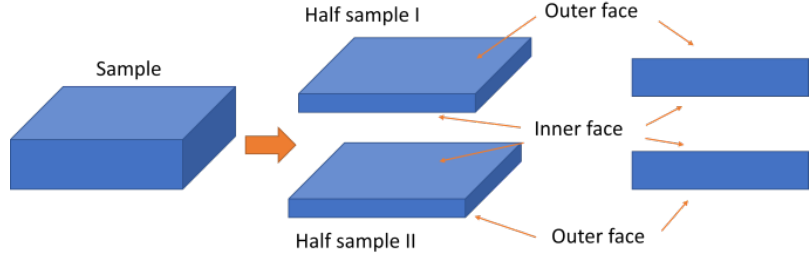
Figure 16. Preparation of the samples.